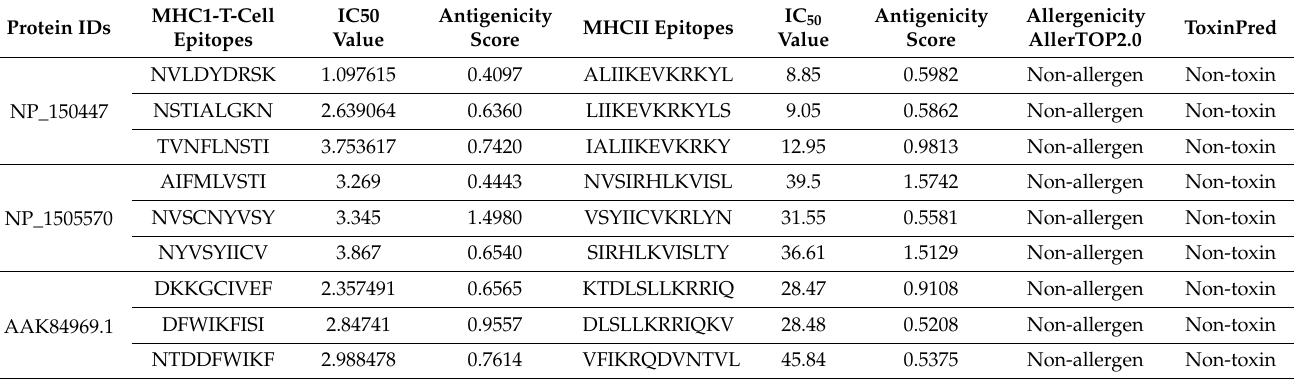
Table 3. The top prioritized MHC1 and MHCII T-cell